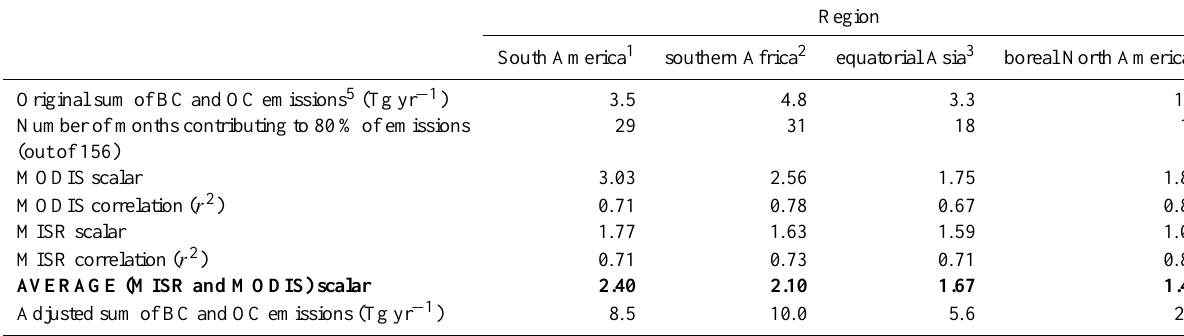
Table 1. Summary of scaling factors for selected biomass burning regions.